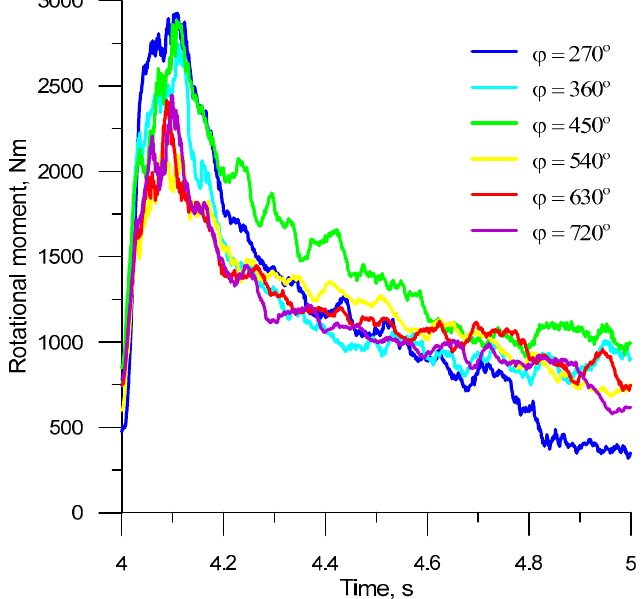
Figure 13. Torque during the fifth revolution of the tool.